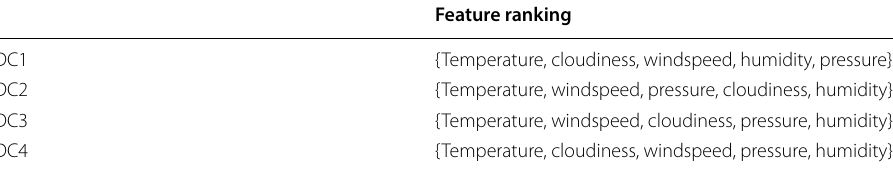
Table 1 Feature ranking result